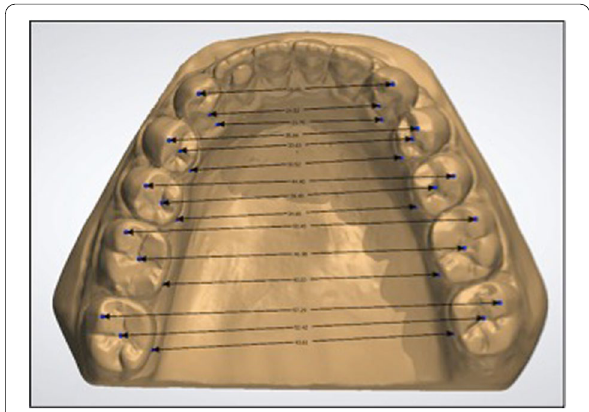
Fig. 1 Example of the measure digitization on a lower